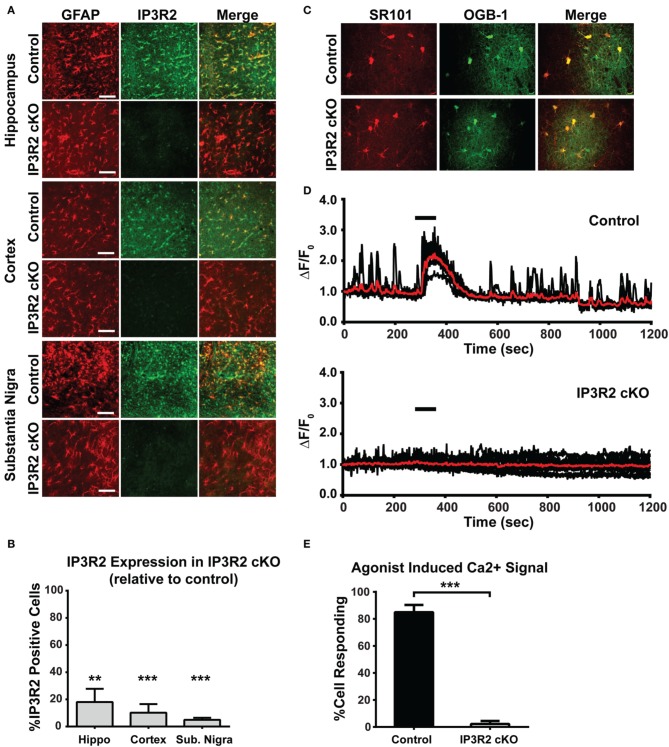
Immunohistochemical and Ca2+ imaging analysis of IP3R2 recombination efficiency. (A) Astrocytes labeled with GFAP (left column) display a high level of colocalization with IP3R2 staining (IP3R2 middle column; Merge with GFAP right column). Scale bar, 100 μm. (B) Quantification of three different brain regions for recombination efficiency in the IP3R2 cKO found high levels of recombination in the brain regions examined. Data are presented as GFAP positive cells colocalizing with IP3R2 relative to control (100% colocalization). (C) Two-photon images of hippocampal sections loaded with SR101 (left) and OGB-1AM (middle) and their colocalization (right). (D) Population Ca2+ traces from representative experiments (Control, n = 7 cells; IP3R2 cKO, n = 12 cells) showing responses to agonist application (black bar; coapplication of 10 μM DHPG, 10 μM carbachol, 10 μM histamine). Red trace represents cell population average for each experiment. (E) Quantification of agonist-induced Ca2+ increases in IP3R2 cKO hippocampal slices in all experiments (Control, n = 97 cells; IP3R2 cKO, n = 63). Error bars indicate s.e.m. **
p < 0.01; ***
p < 0.001.